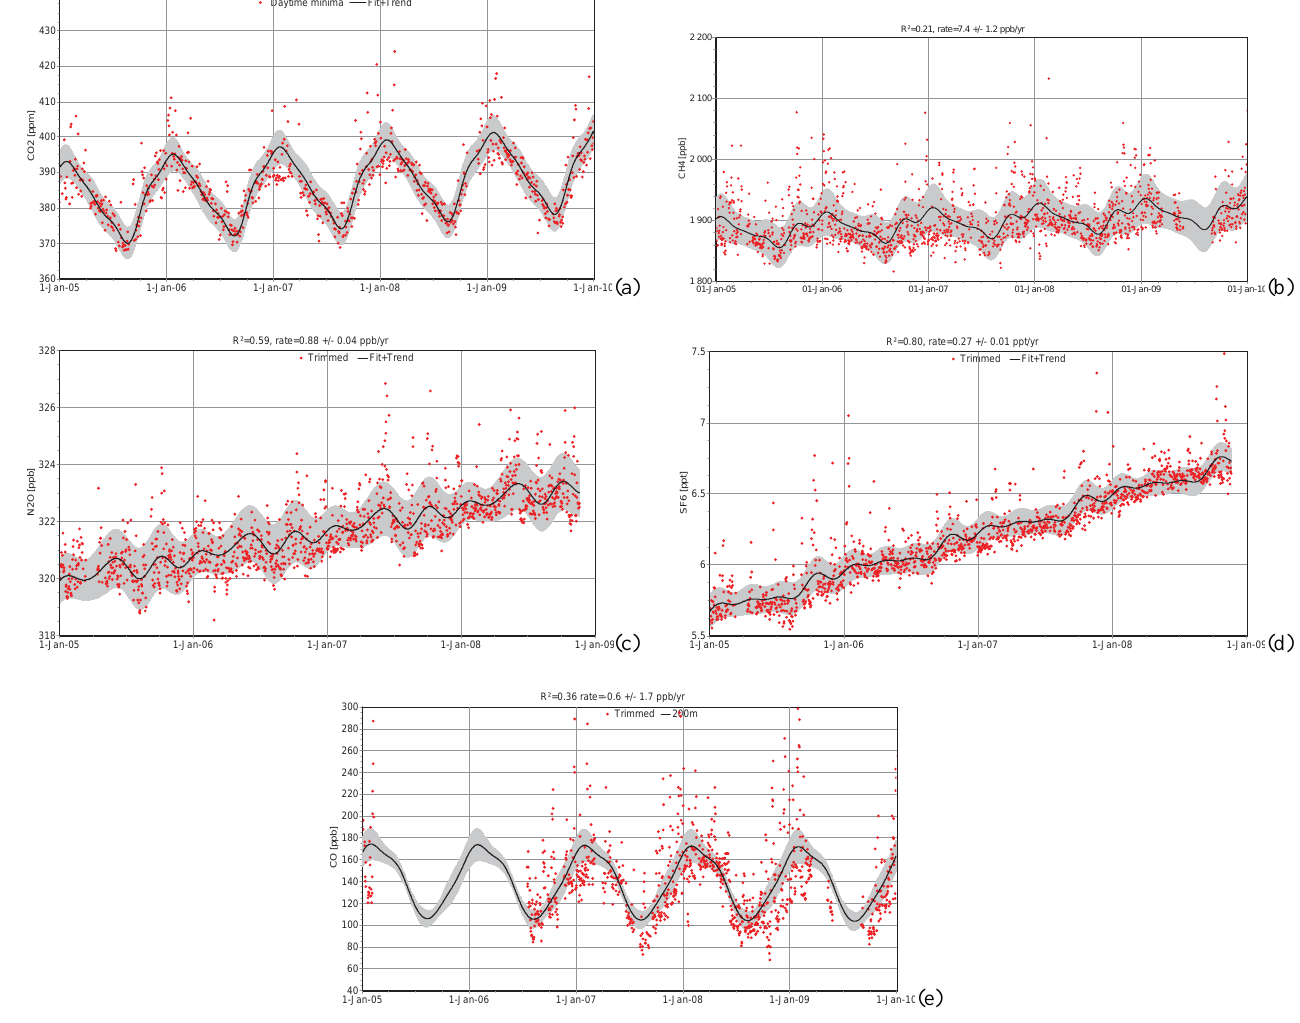
Fig. 14. Time series of Cabauw CO 2 (a) , CH 4 (b) , N 2 O (c) , SF 6 (d) , CO (e) daily trimmed means (50%) (method B) of ambient concen- trations at 200ma.g.l. (red dots), with fitted harmonic trend for the period 2005–2010 (CO 2 , CH 4 , CO) or 2005–2009 (N 2 O, SF 6 ): (black lines), standard deviation of the daily trimmed means (grey